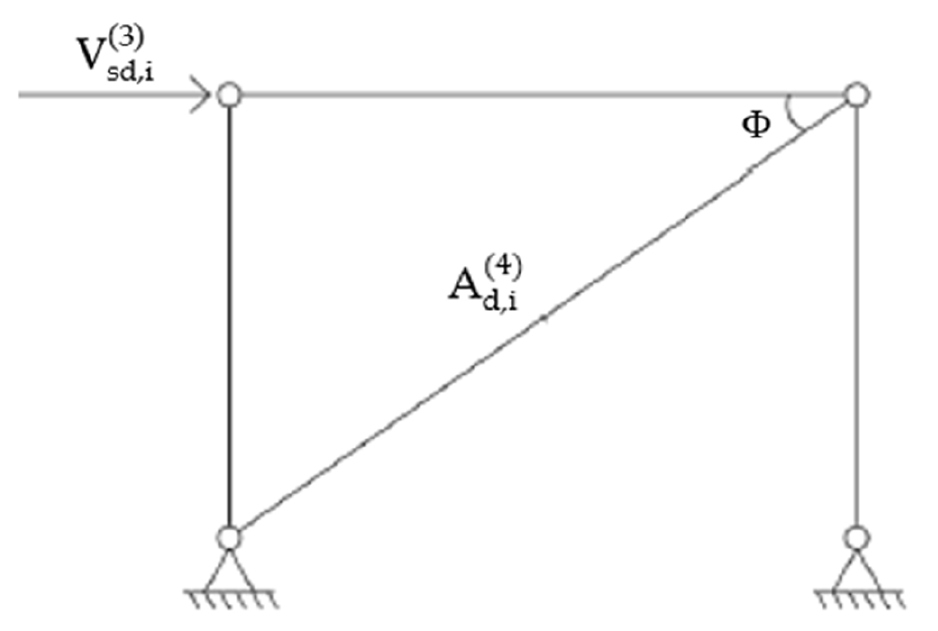
Figure 8. Calculation scheme of step 4.